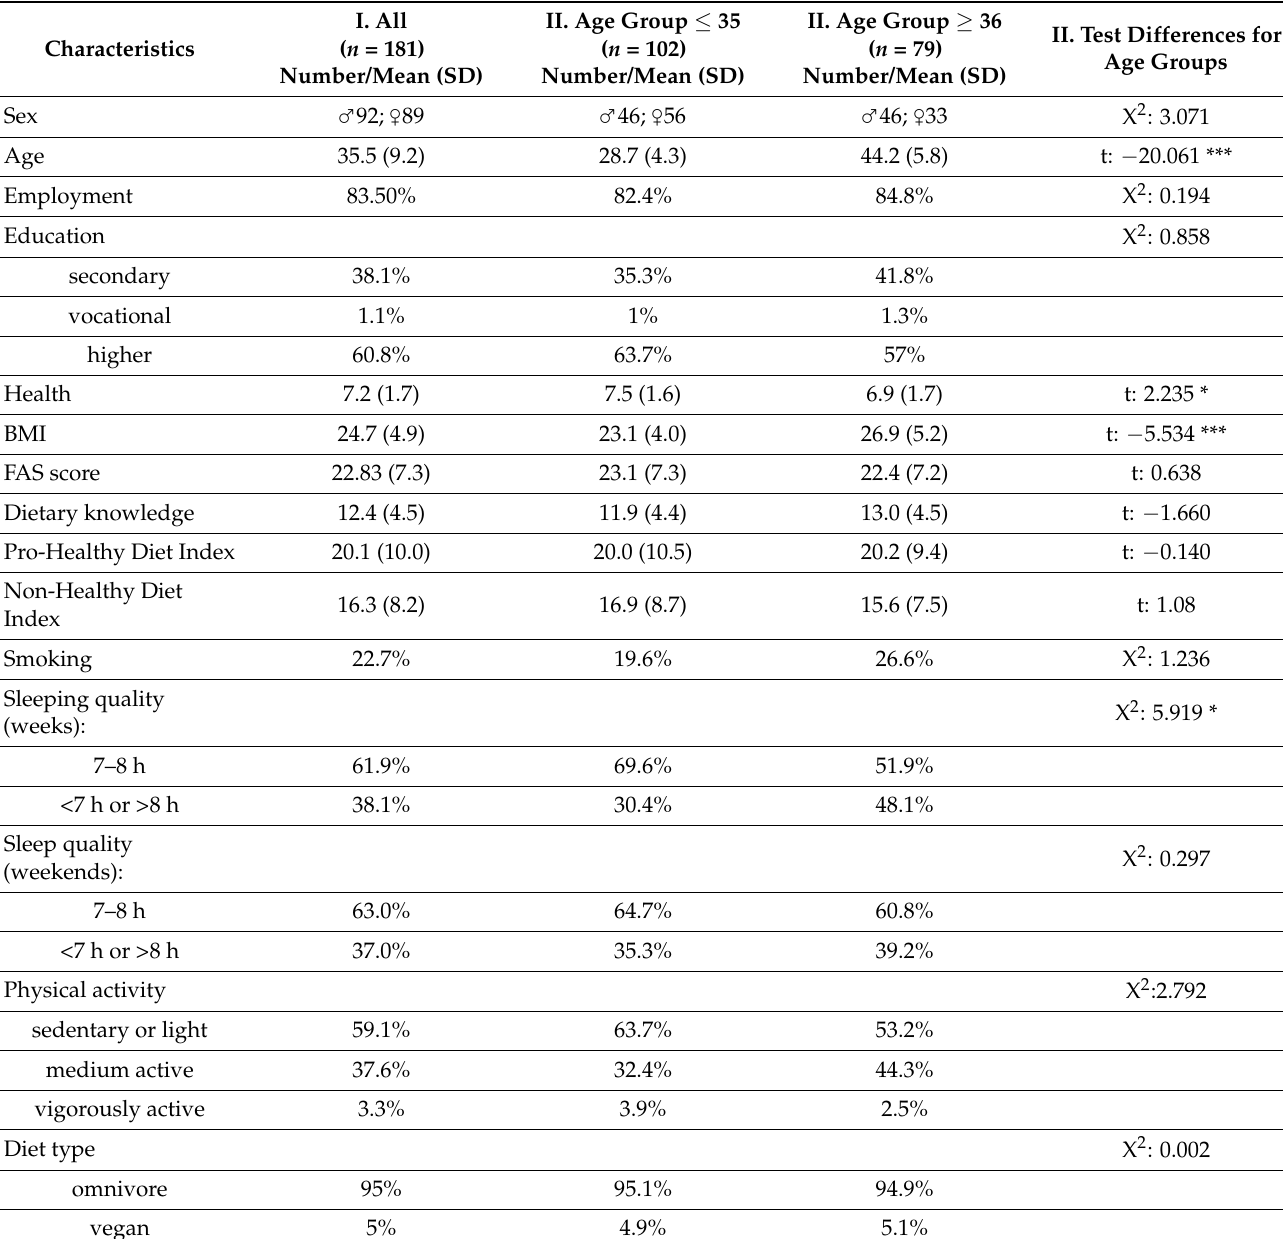
Table 1. Participant characteristics, descriptive statistics, and test differences for: I. all participants, II. each age group.